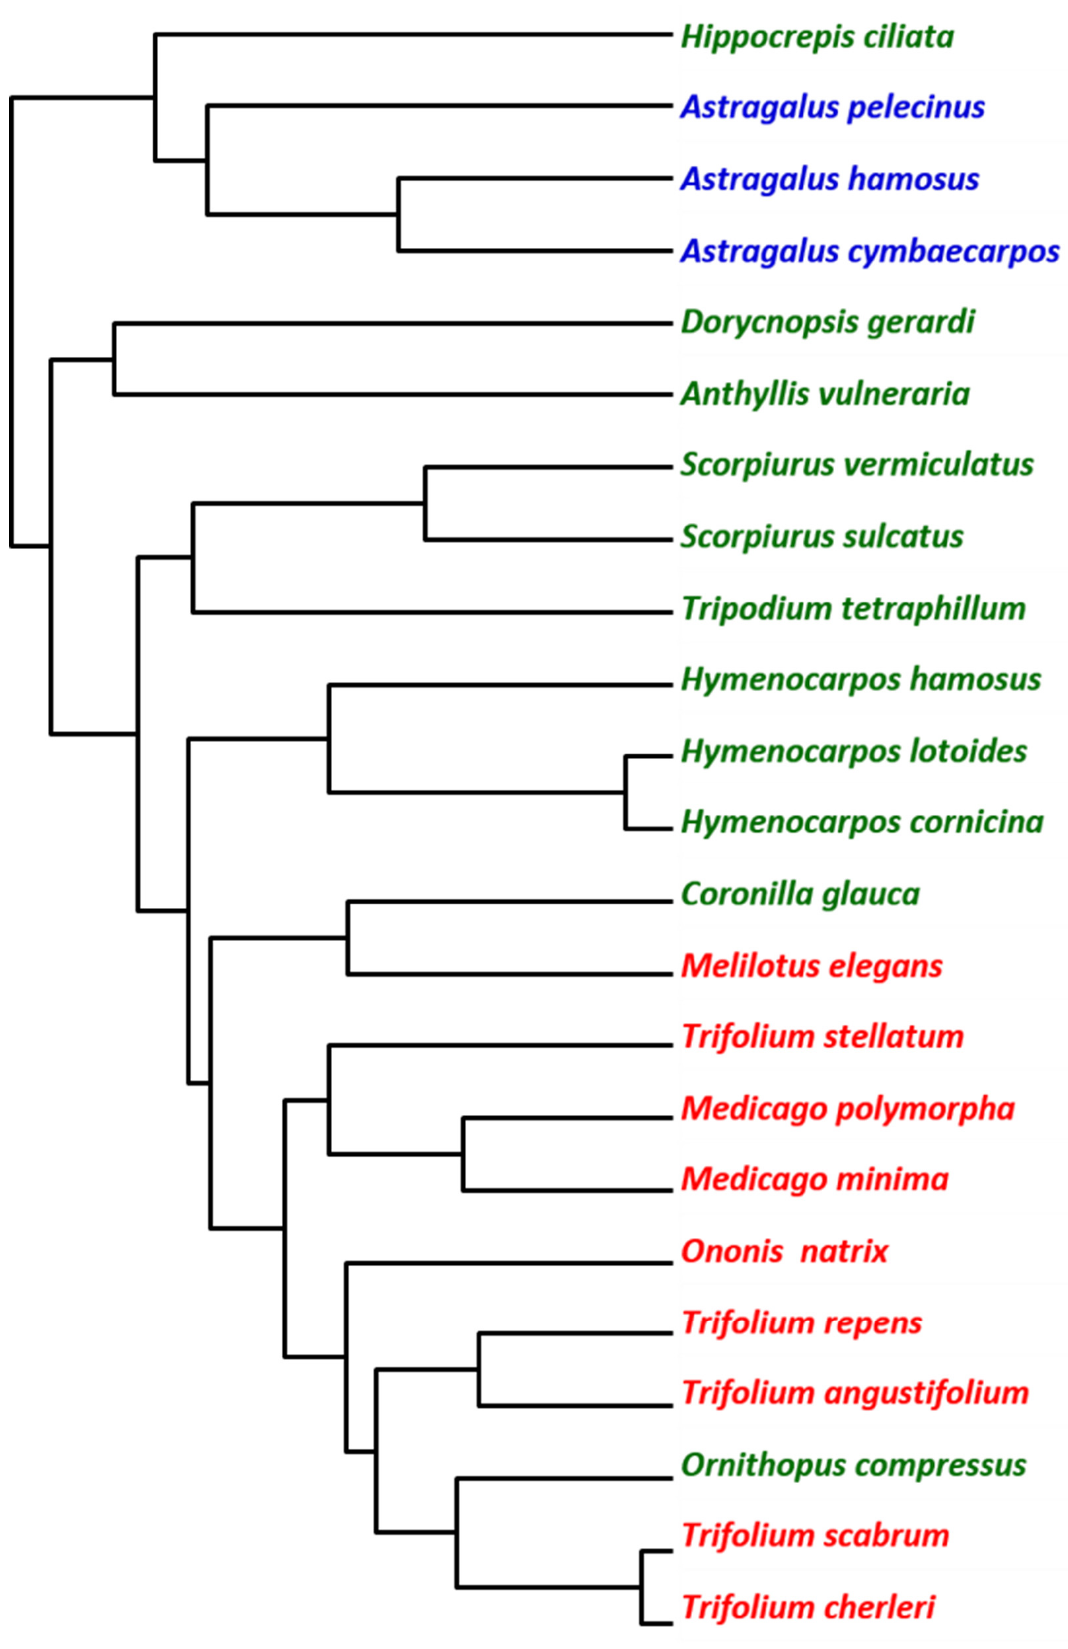
Figure 2. Dendrogram based on the seed amino acid composition.